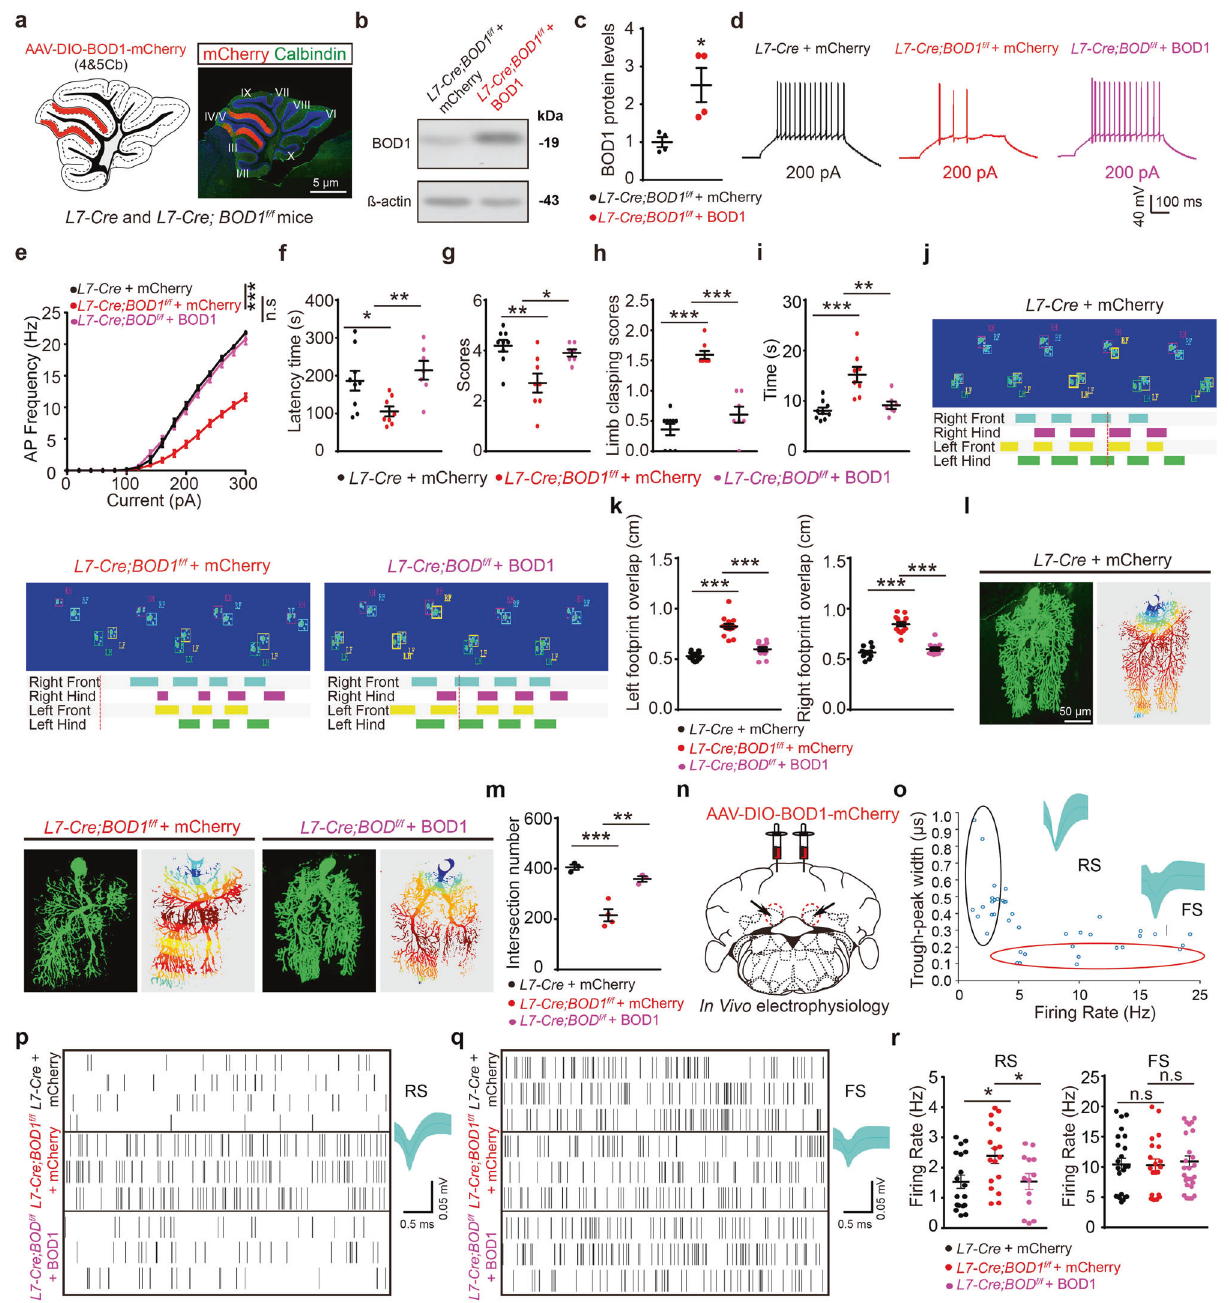
Fig. 6 Overexpression BOD1 in the IV/V lobe of cerebellum alleviates ataxia-like behaviors in mice. a Representative images of mCherry (red) and Calbindin (green) double-positive neurons in cerebellar IV/V lobe of L7-Cre and L7-Cre; BOD1 f/f mice. b , c Representative image ( b ) and quanti fi cation ( c ) of BOD1 expression by western blot analysis after AAV-DIO-BOD1-mCherry or control injection ( n = 4 mice per group; * P <0.05; unpaired two- tailed Student ’ s t test). d Representative traces of AP responses to positive current injection treatments at 200 pA in mCherry + neuron of L7-Cre and L7-Cre; BOD1 f/f mice with AAV-DIO-mCherry or AAV-DIO-BOD1-mCherry injection. e Quanti fi cation of AP frequency across 0 – 300 pA current injections in 20-pA steps ( n = 25 cells from three mice per group; *** P <0.001; two-way ANOVA followed by Turkey ’ s multiple comparisons test). f – i After AAV-DIO-mCherry or AAV-DIO-BOD1-mCherry injection to L7-Cre and L7-Cre; BOD1 f/f mice, ataxia-related behaviors were examined ( n = 9, 8, 7 mice per group; * P <0.05; ** P <0.01; *** P < 0.001; one-way ANOVA followed by Turkey ’ s multiple comparisons test). j , k Representative images of Gait footprint ( j ), Quanti fi cation of the left and right footprint overlap for Gait footprint ( k ). n = 13, 15, 12 mice per group, respectively; *** P < 0.001; one-way ANOVA followed by Turkey ’ s multiple comparisons test. l Representative images (left) and heat map (right) of PCs after 8h of AAV-DIO- mCherry or AAV-DIO-BOD1-mCherry injection. m Quanti fi cation of intersection number in dendritic branches ( n = 3 mice per group; ** P < 0.01; *** P <0.001; one-way ANOVA followed by Turkey ’ s multiple comparisons test). n Diagram depicting the experimental approach for combining viral injection and in vivo electrophysiology recording. o Units were classi fi ed into clusters by peak-to-valley width and fi ring rate. RS glutamatergic neurons, FS GABAergic neurons. p , q Representative raster plot and waveform of RS ( p ) or FS ( q ). r Quanti fi cation fi ring rate of glutamatergic ( n = 18, 16, 13 cells from three mice) and GABAergic neurons ( n = 23, 20, 29 cells from three mice) (* P <0.05; one-way ANOVA followed by Turkey ’ s multiple comparisons test). The error bars represent means ±s.e.m; ns not signi fi